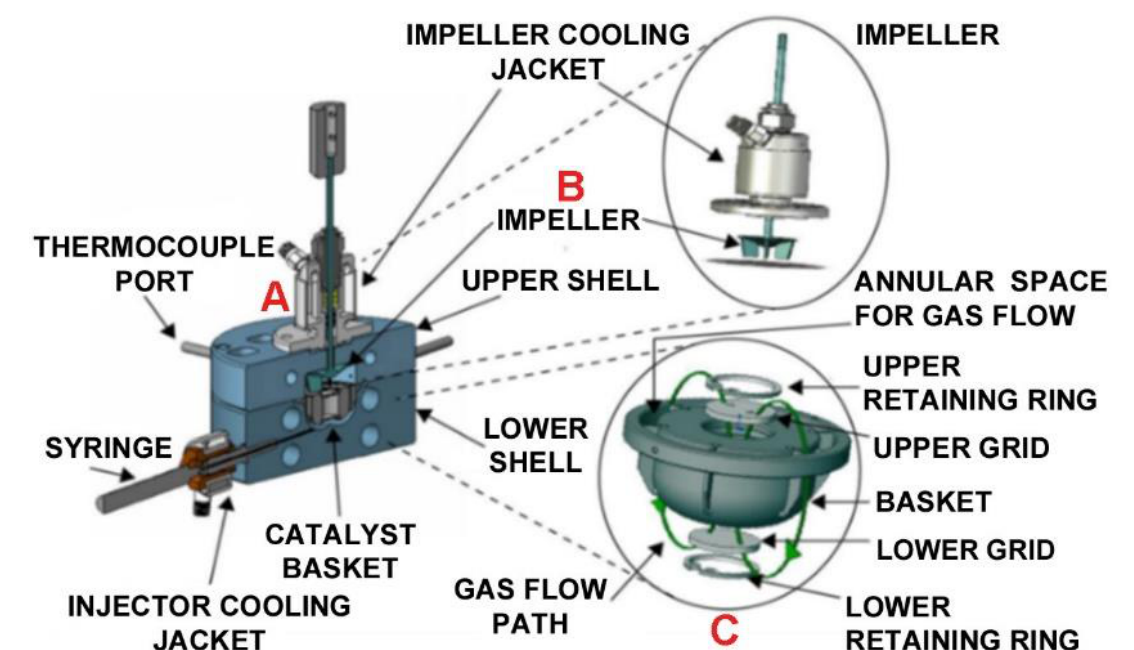
Figure 2. Schematic Description of the 1992-CREC Riser Simulator and its Various Components: (A) body of the reactor unit, (B) impeller, (C) catalyst basket equipped with upper and lower grids and vertical baffles. Adapted with permission from Ref. [13], Copyright 2013, Copyright owner’s R. Quddus.